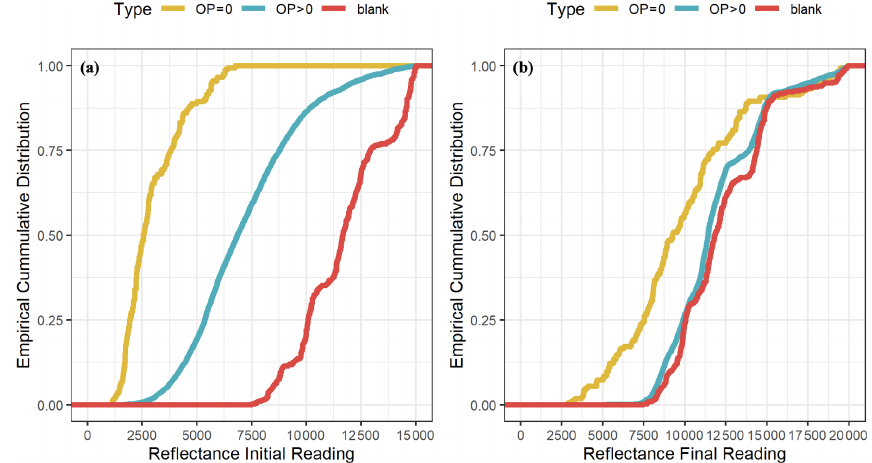
Figure 7. Cumulative plots of the laser reflectance initial (a) and final (b) readings for all blanks ( n = 512) and CSN samples with ( n = 3894) and without optical charring correction ( n = 179). All laser readings are in arbitrary units (a.u.) and are from Sunset